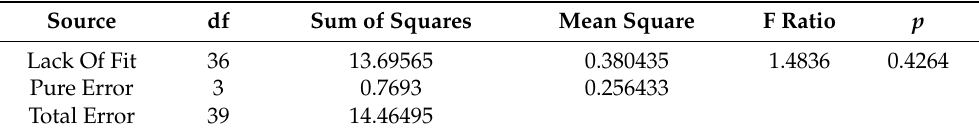
Table 3. ANOVA evaluation of the regression model (MSNm) of the layer thickness ( t h ). Source df Sum of Squares Mean Square F Ratio p Model 14 341.8378 24.417 65.8324 <0.0001 * Error 39 14.46495 0.3709 C. Total 53 356.3028